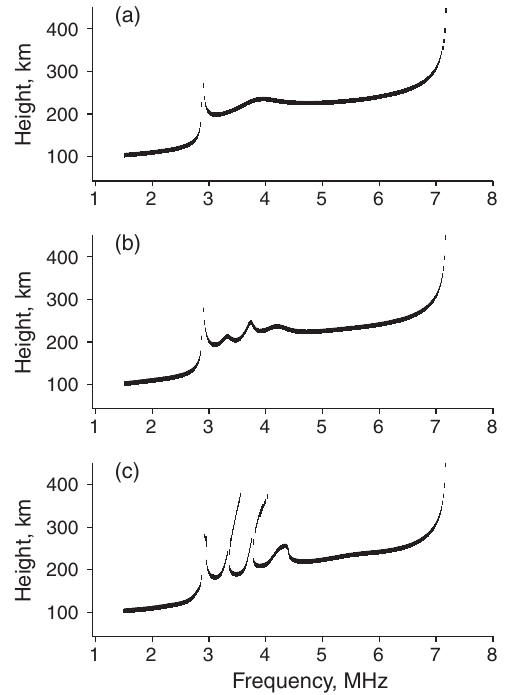
Figure 6. Synthesized ionograms using ray tracing for unperturbed density profile (a) , maximum density perturbation of 1% (b) , and 4% (c) .